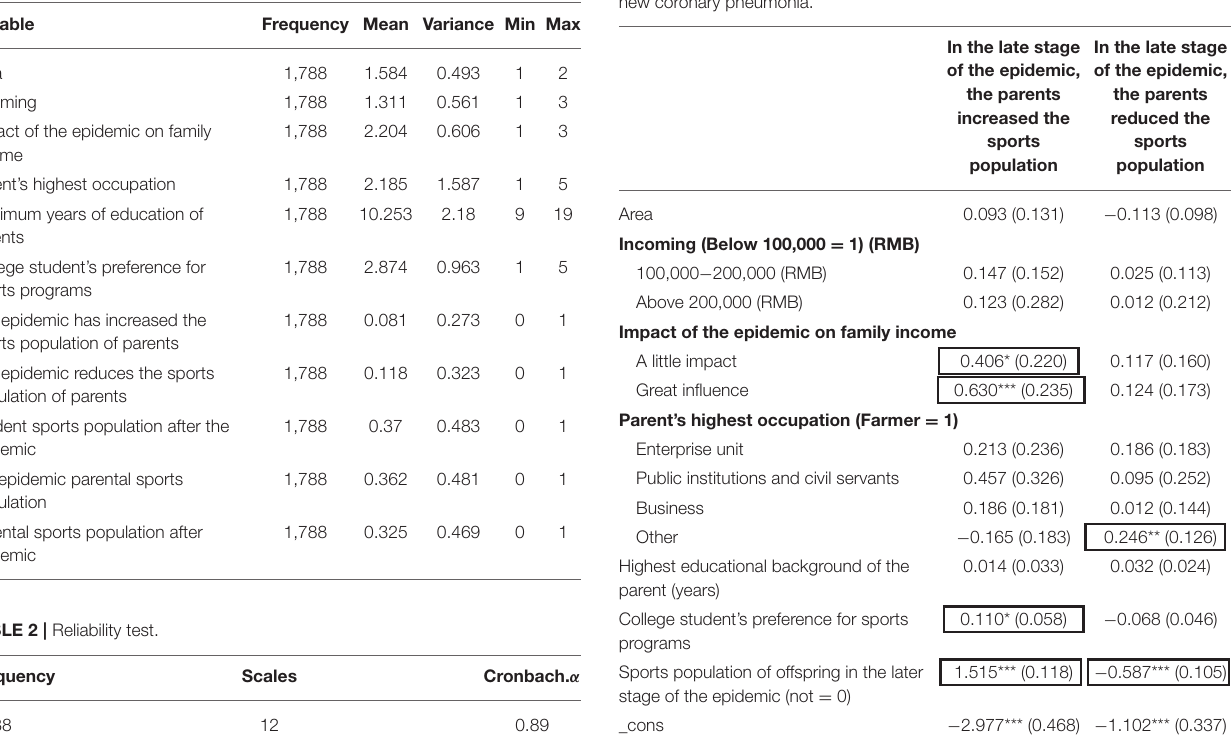
TABLE 1 | Variable descriptive statistics.